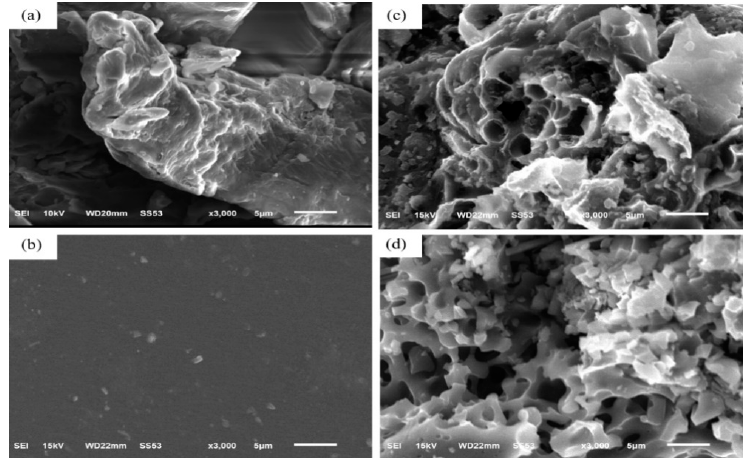
Figure 2. SEM images of ( a ) Carboxymethylcellulose (CMC) powder, ( b ) Styrene–Butadiene Rubber (SBR) film, ( c ) CMC—after pyrolysis, ( d ) SBR—after pyrolysis. (SBR) film, ( c ) CMC—after pyrolysis, ( d ) SBR—after